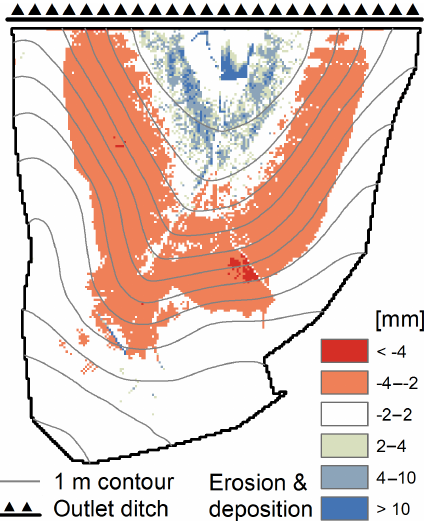
Figure 3. Spatial patterns of total soil erosion and deposition after hundred years of simulation. Negative values indicate erosion and positive values